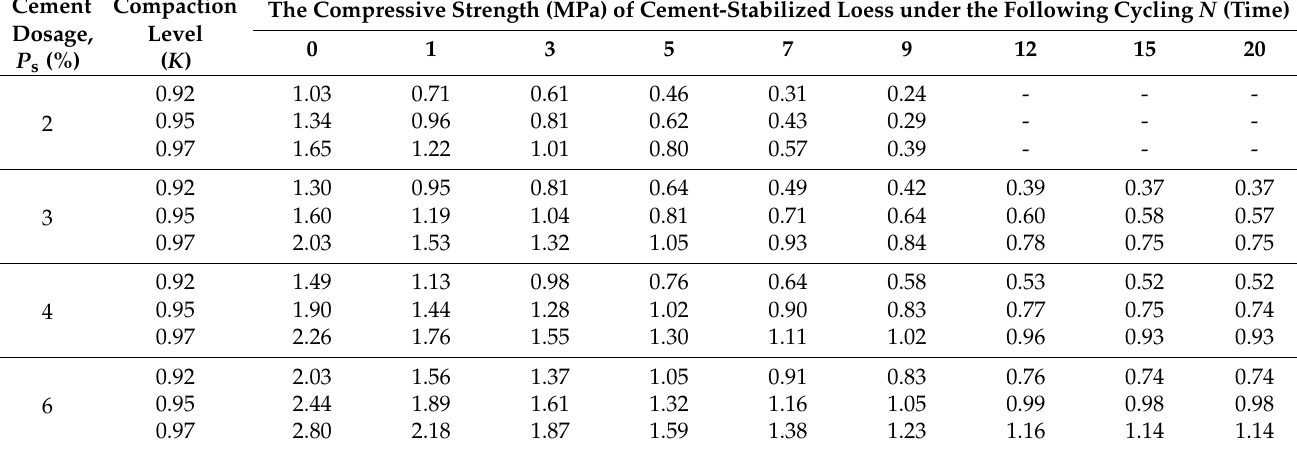
Table 7. The 28-day compressive strength test results of cement-stabilized loess under freeze–thaw cycling. Cement